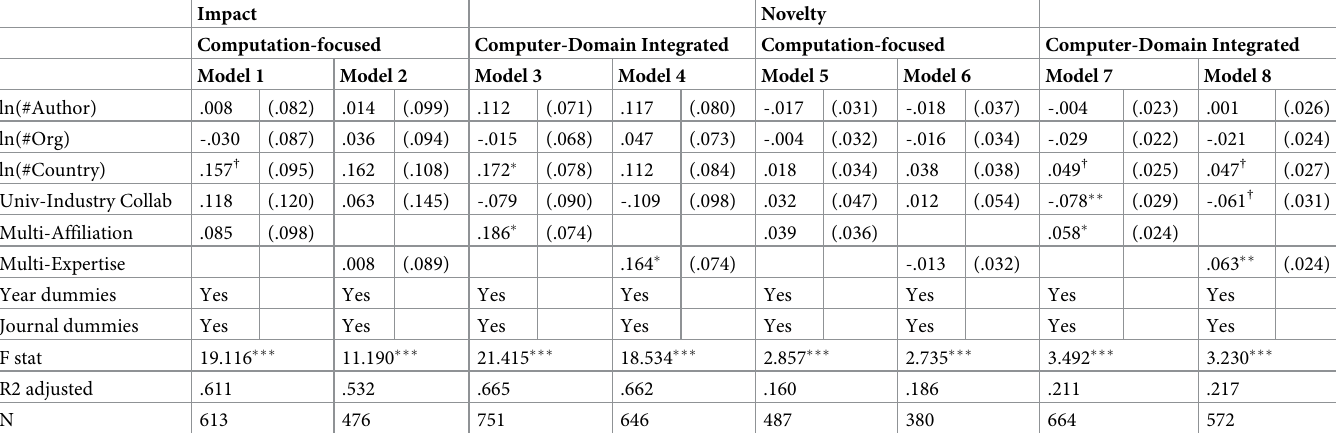
Table 4. Use of machine: Computation-focused vs. computer-domain integrated projects (ML-related projects